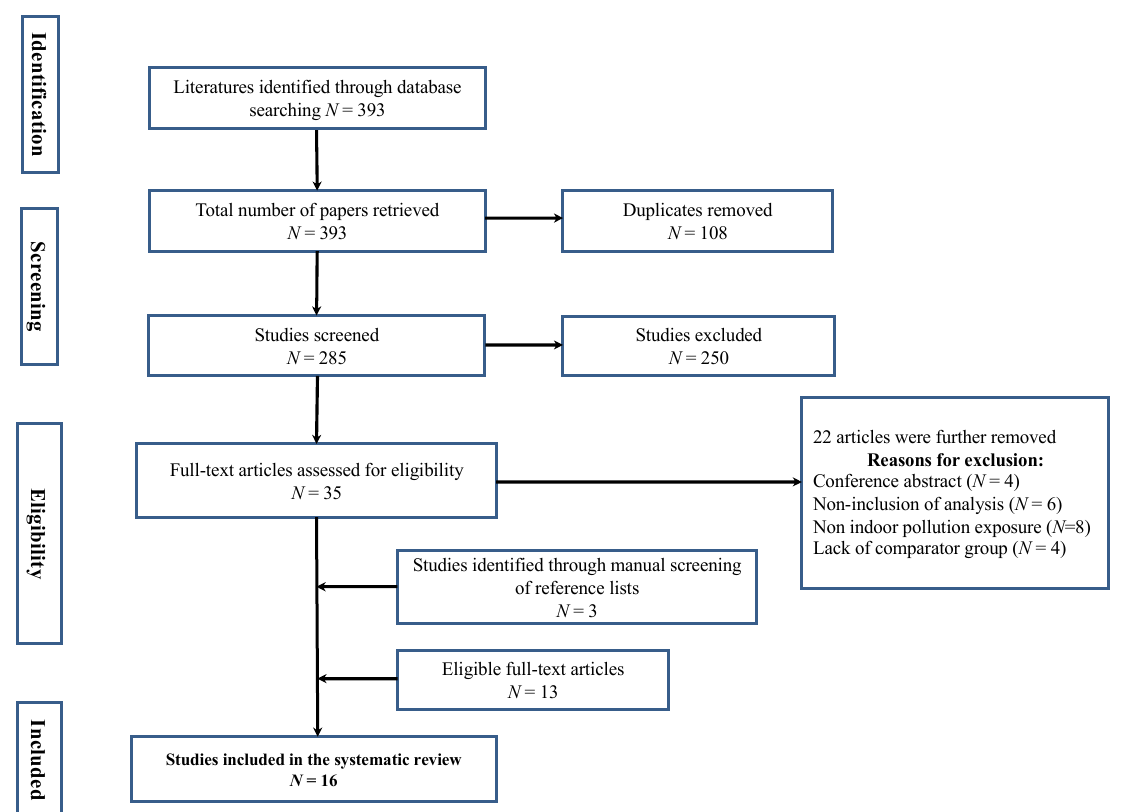
Figure 1. The PRISMA flow diagram for the selection of studies for the systematic review.